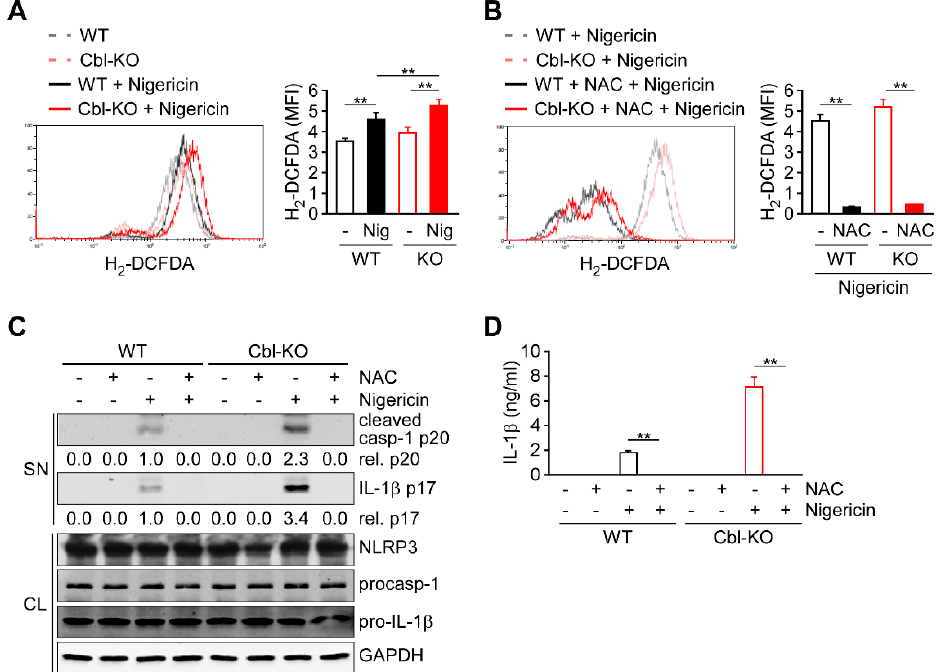
Figure 3. Reactive oxygen species (ROS) production increased in Cbl-deficient THP-1-derived macrophages and enhanced NLRP3 inflammasome activation. ( A ) The production of cellular ROS in WT and Cbl-KO THP-1-derived macrophages treated with or without nigericin for 30 min was measured using 2 ′ ,7 ′ -dichlorodihydrofluorescein diacetate (H 2 -DCFDA). ( B ) The production of cellular ROS in WT and Cbl-KO THP-1-derived macrophages pretreated with or without N-acetyl-L-cysteine (NAC) and stimulated with nigericin for 30 min was measured using H 2 -DCFDA. ( C ) Immunoblot analysis of caspase-1 (p20) and interleukin (IL)-1 β (p17) in culture supernatants (SN) and NLRP3 inflammasome molecules and GAPDH in cell lysates (CL) of WT and Cbl-KO THP-1-derived macrophages that were pretreated with or without NAC and then stimulated with nigericin. ( D ) Enzyme-linked immunosorbent assay of IL-1 β in the supernatants of WT and Cbl-KO THP-1-derived macrophage cultures pretreated with or without NAC and then stimulated with nigericin. ** p < 0.01. All results are presented as the mean ± SD of three independent experiments and were analyzed using Student’s t -test.